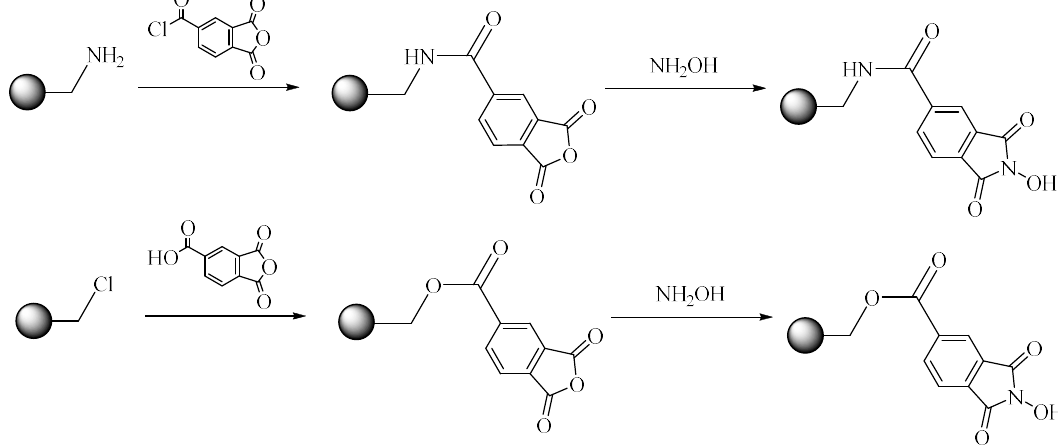
Figure 2. N -hydroxyphthalimide (NHPI) immobilization on various polymer supports via amide or ester bonds.